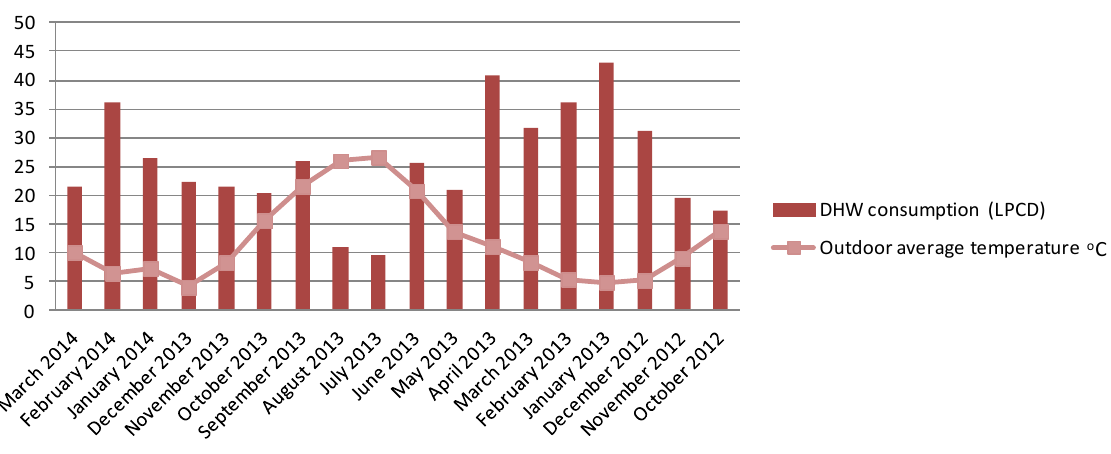
Figure 3. DHW consumption (LPCD) in one apartment.